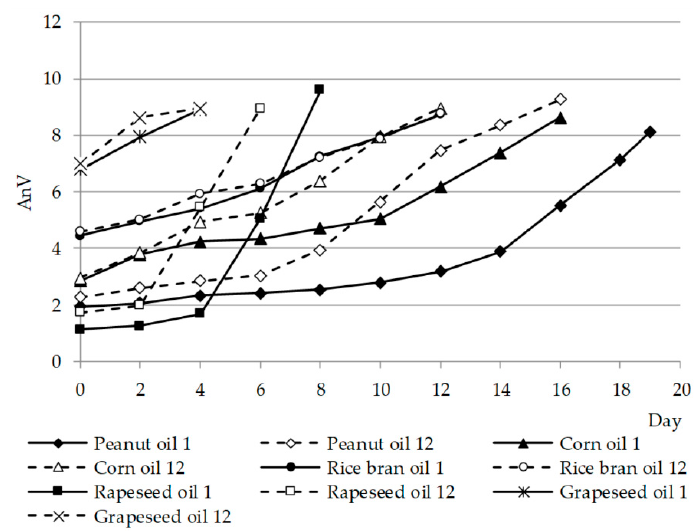
Figure 3. Anisidine (AnV) changes of the selected oils in the Schaal Oven Test in the 1st and 12th months of storage.